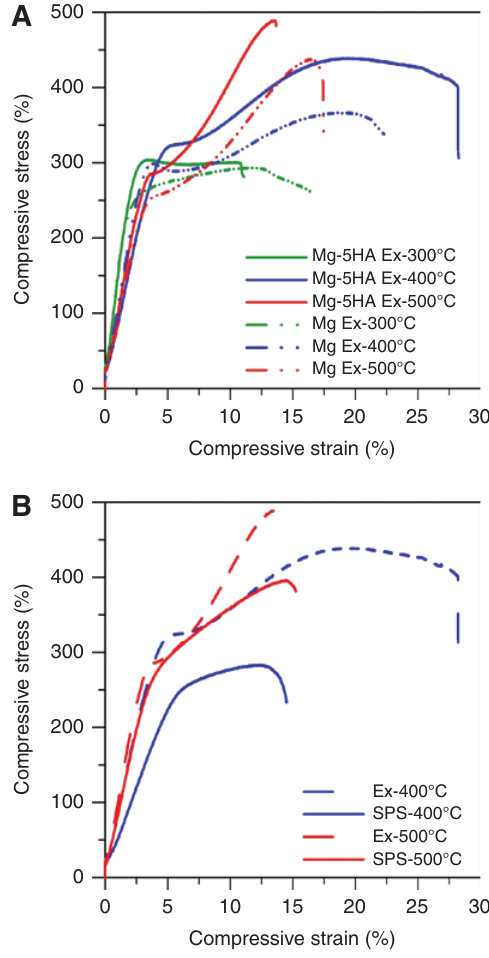
Figure 8: Compressive curves of Mg-HA prepared by mixing of powders in planetary mill and subsequent extrusion at (A) 300 ° C and (B) 500 ° C.